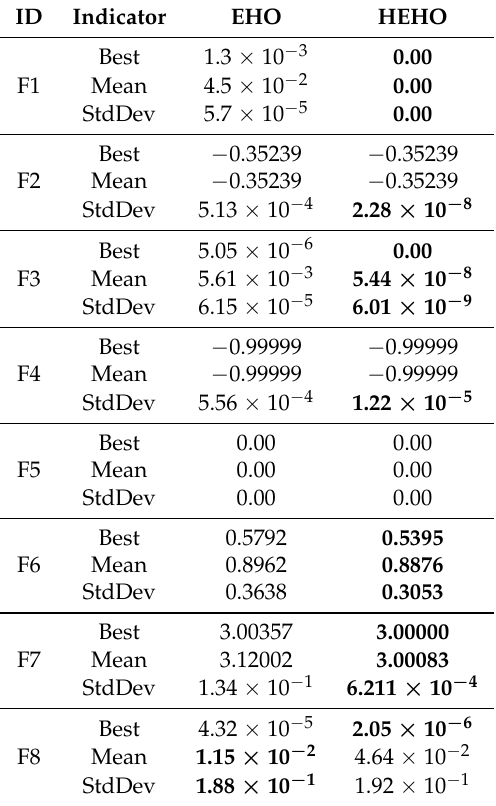
Table 3. Comparative analysis—elephant herding optimization (EHO) vs. hybridized EHO (HEHO). (best results for each performance indicator are marked